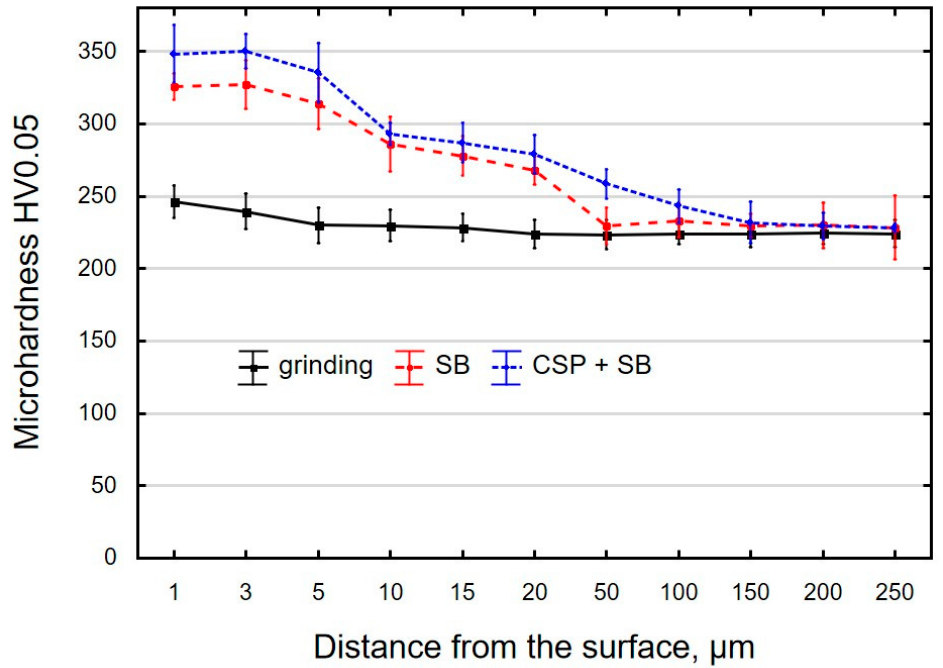
Figure 9. Microhardness of the surface layer in the samples after grinding (pre-treatment), slide burnishing (SB) and centrifugal shot peening and slide burnishing (CSP + burnishing (SB) and centrifugal shot peening and slide burnishing (CSP + SB).